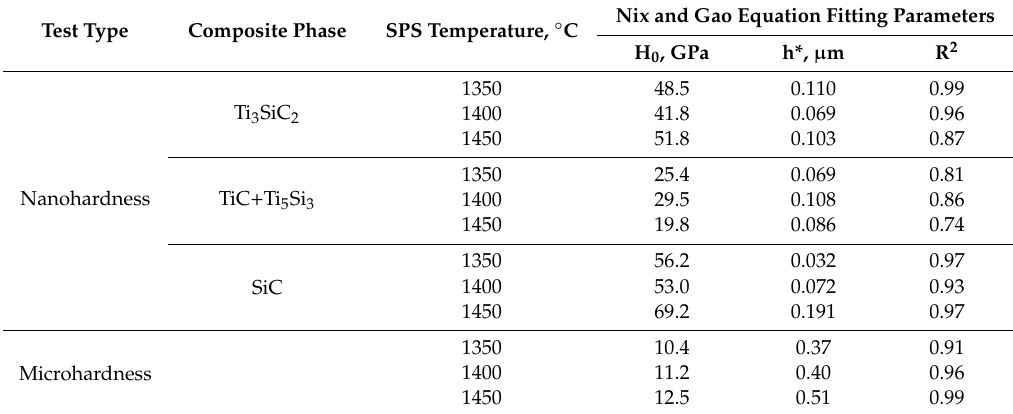
Figure 10. Application of Nix and Gao model to nanohardness experimental data of: Ti 3 SiC 2 ( a ); TiC + Ti 5 Si 3 ( b ) and SiC ( c ) phases of composites SPSed at 1350, 1400 and 1450 ◦ C. Table 4. Nix and Gao equation fitting parameters of composites SPSed at 1350, 1400 and 1450 ◦